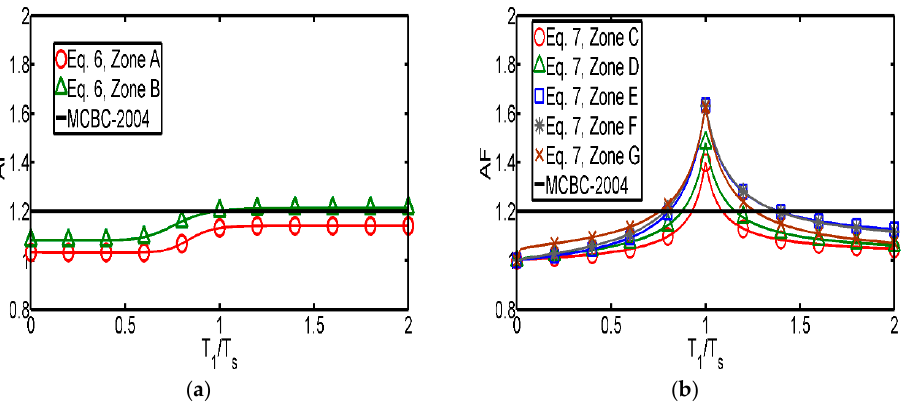
Figure 9. Comparison of the strength amplification factors obtained with Equations (6) and (7) with those recommended by MCBC-2004, corresponding to µ = 2 and α = 0.02. ( a ) Firm ground; ( b ) Intermediate and soft